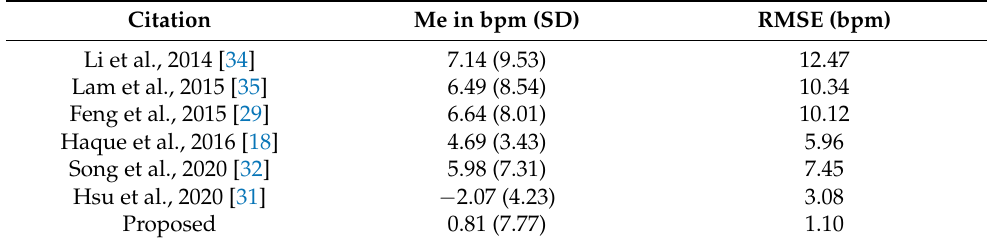
Table 11. Results of comparison with previous